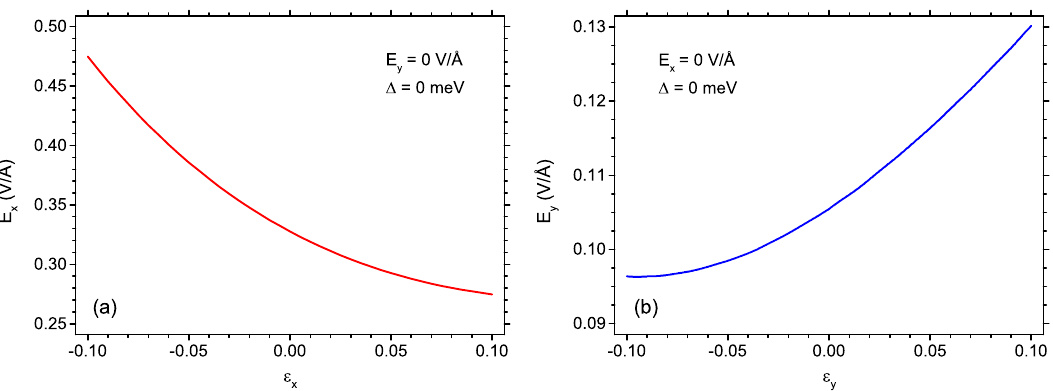
Figure 6. The dependence of the critical electric field along the given direction on the strain along the same direction: ( a ) x direction and ( b ) y direction, in the absence of other fields. The critical field corresponds to switching between S = 1 and S = 0